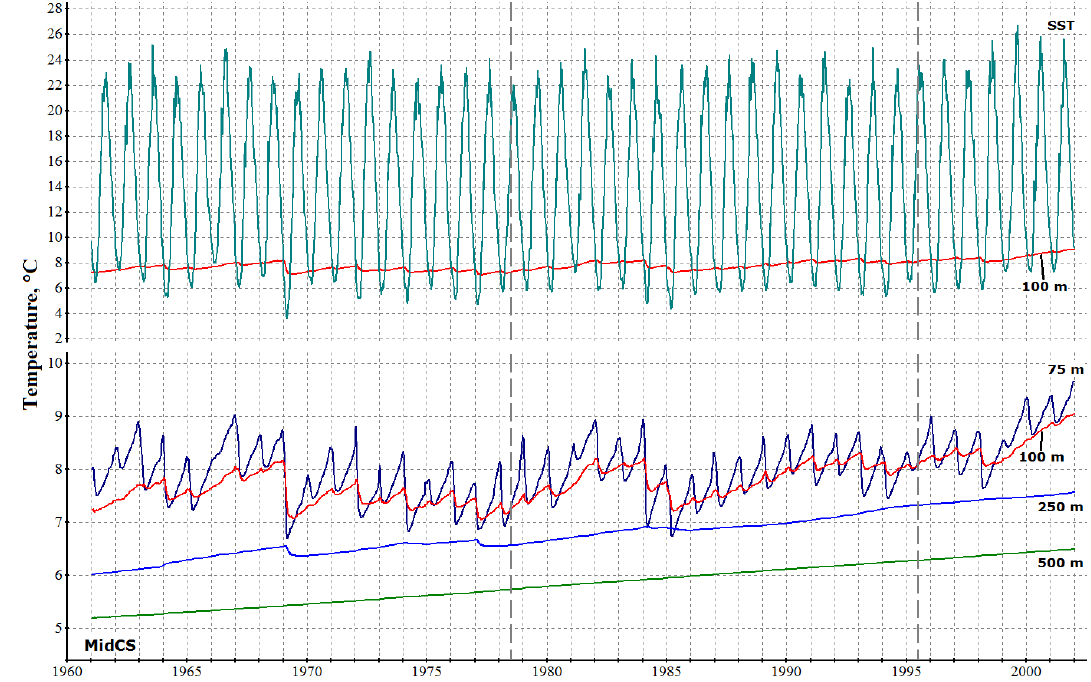
Figure 10. Evolution of temperature at different depths (SST – sea surface temperature) averaged over the MidCS basin ( ◦